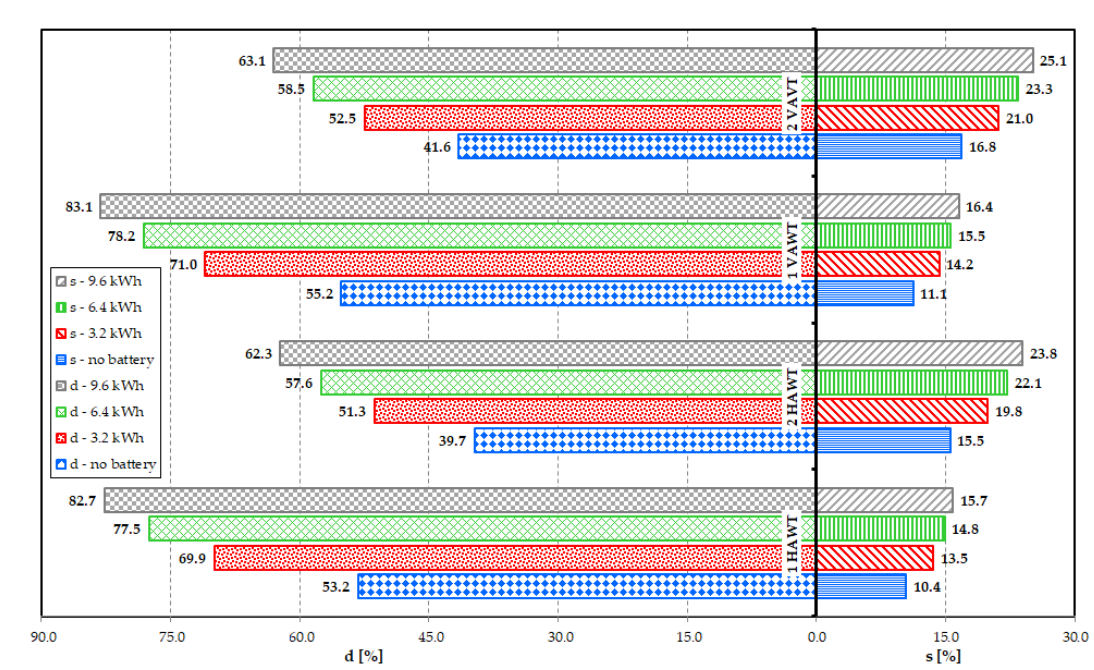
Figure 12. s and d indexes as a function of WT configuration (type and number) and battery storage capacity for Naples.